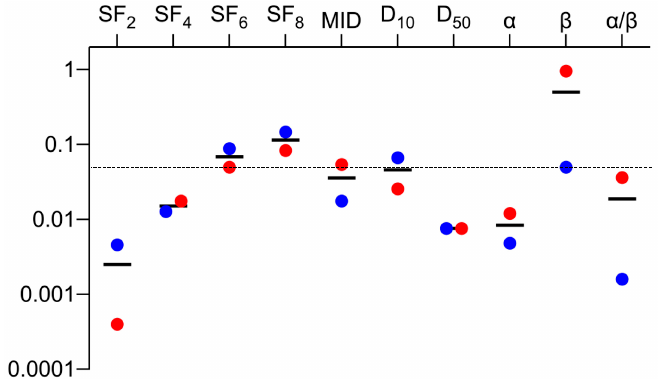
Figure 3. Summary of the p values for datasets A and B. MID, mean inactivation dose. Black lines indicate the mean values.